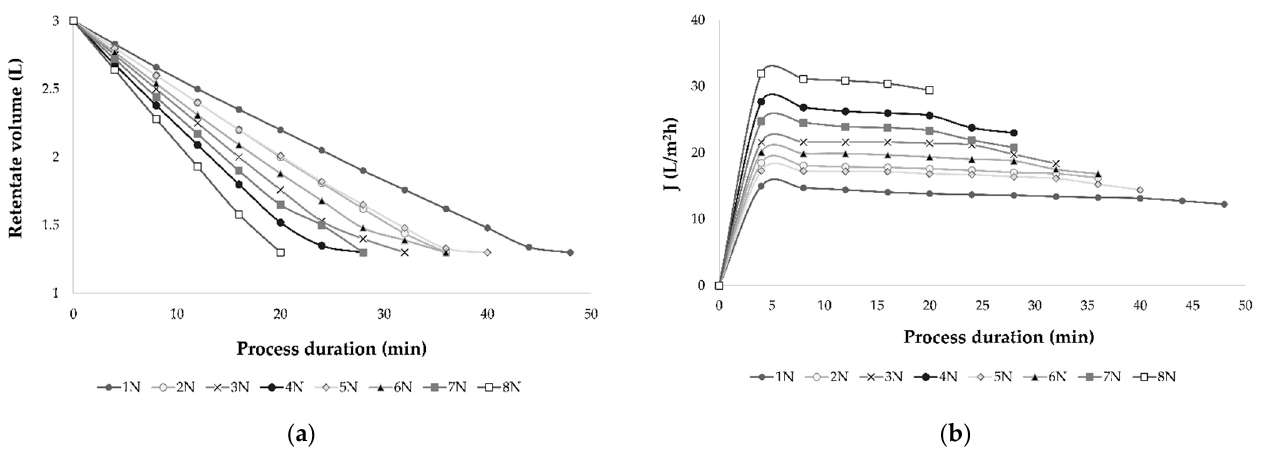
Figure 3. The retentate volume (L) reduction ( a ) and permeate flux J (L/m 2 h) decline ( b ) during the nanofiltration process of conventional and ecological Cabernet Sauvignon red wine. Abbreviations: N–nanofiltration process; 1–2.5 MPa with cooling; 2–3.5 MPa with cooling; 3–4.5 MPa with cooling; 4–5.5 MPa with cooling; 5–2.5 MPa without cooling; 6–3.5 MPa without cooling; 7–4.5 MPa without cooling; 8–5.5 MPa without cooling.